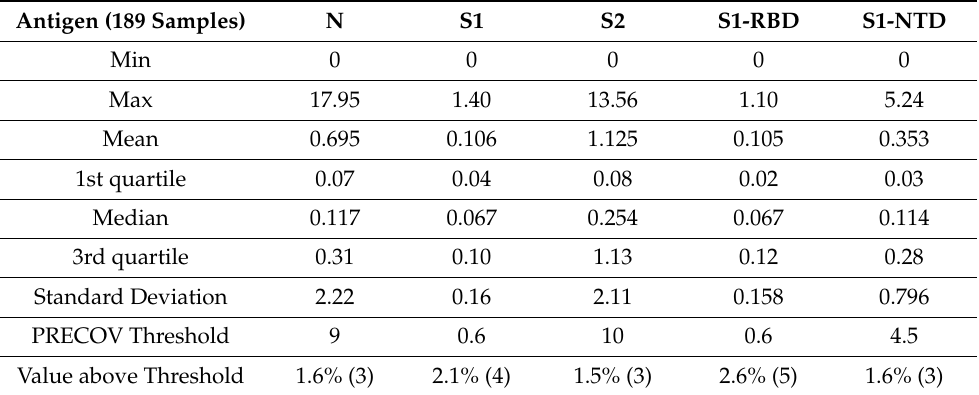
Table 1. ELISA Optical density values of the of the control samples, PRECOV threshold, and percentage of control samples above the threshold. The PRECOV thresholds were determined modeling the values distribution of the control